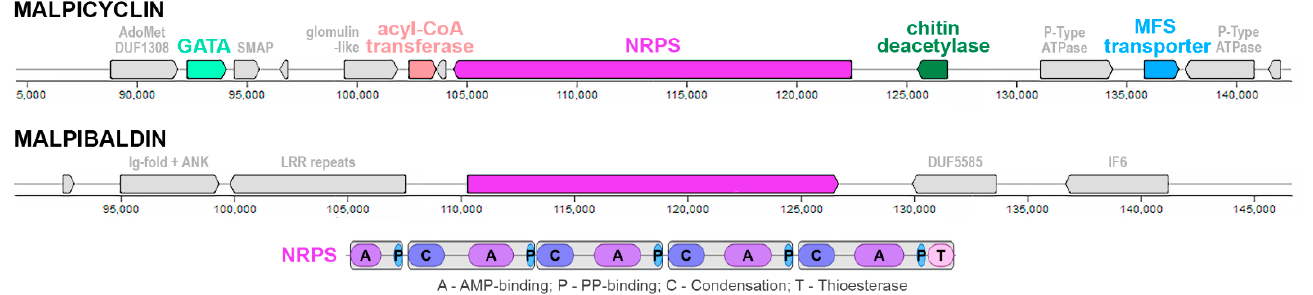
Figure 5. Schematic architecture of malpicyclin (GCA_000507065__21_glim) and malpibaldin (GCA_000507065__29_glim) clusters in the M. alpina B6842 assembly GCA_000507065. The malpibaldin NRPS region is surrounded by repeat-rich and disordered protein coding genes.